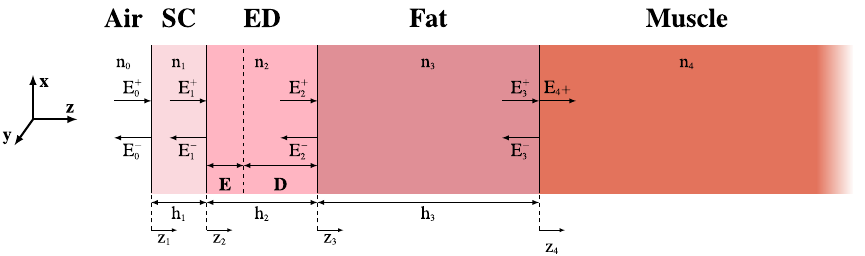
Figure 1. Four layer model employed for calculations of reflection, power deposition, and heating. The model includes SC, viable epidermis (E), dermis (D), fat, and